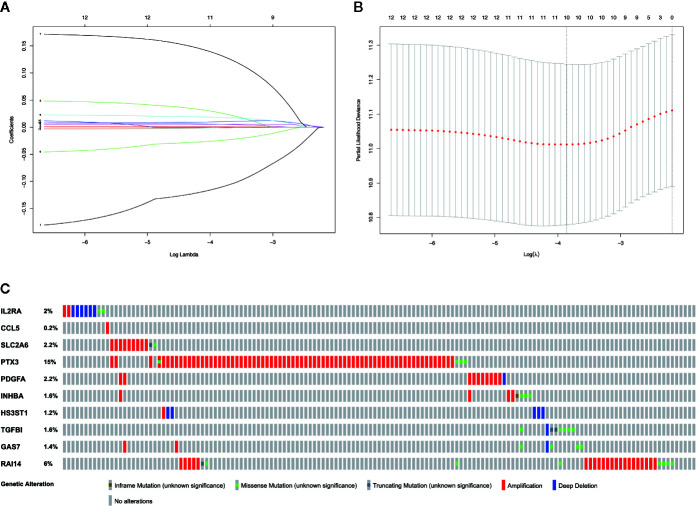
Establishment of prognostic gene signature by LASSO regression analysis. (A) LASSO coefficient profiles of the 12 prognostic MGMs in the training dataset. (B) A coefficient profile plot was generated against the log (lambda) sequence. (C) Genetic alteration of the ten genes in the TCGA-HNSCC cohort (TCGA, Firehose Legacy).